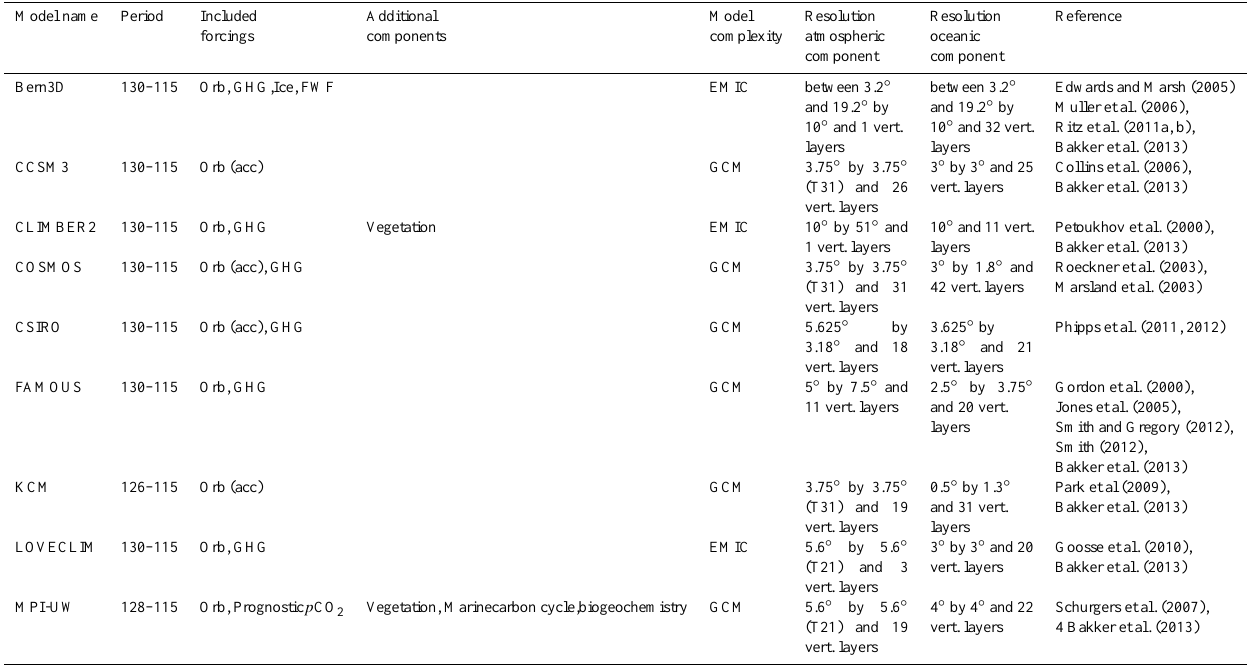
Table 1. Overview of transient LIG climate simulations. For each simulation included in this study the model name is given, the period for which the simulation is performed (in thousands of years before present), the included forcings (Orb = orbital; acc = 10-fold acceleration of orbital forcing; GHG = Greenhouse gas concentrations; Ice = remnants of glacial continental ice sheets in NH; FWF = freshwater fluxes related to remnant ice sheets), components that are included in addition to the atmosphere, ocean and sea ice, the model complexity (EMIC = earth system model of intermediate complexity; GCM = general circulation model), the resolution of the atmospheric and oceanic model components and references to publications in which more details on the LIG simulations and the model specifics can be